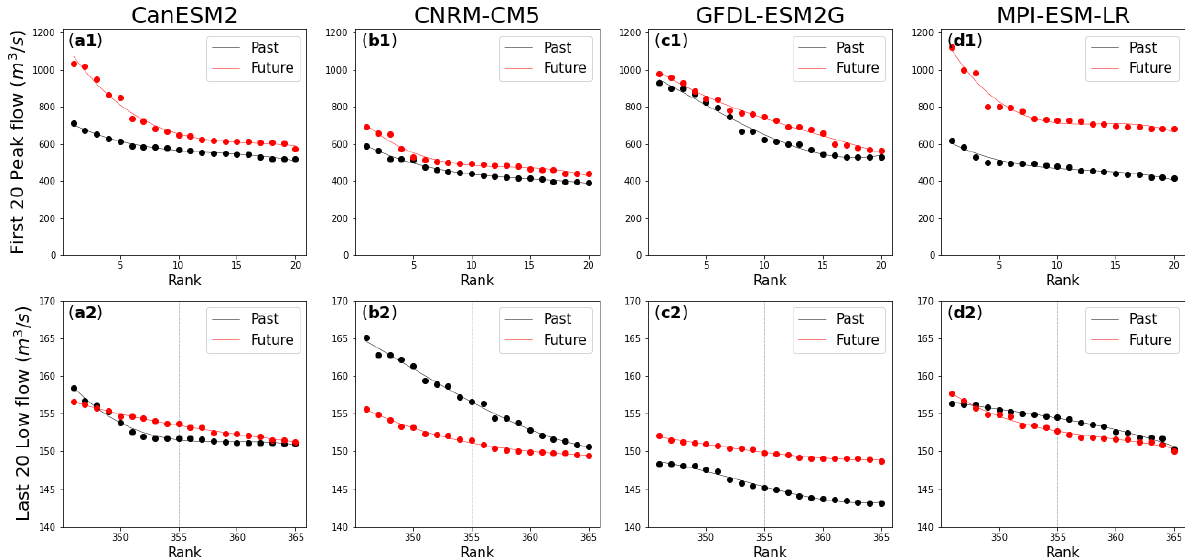
Figure 11. First 20 peak-flow events and the last 20 low-flow events of daily average discharge values of the past and future 20 years of the selected GCMs: CanESM2 ( a1 , 2 ), CNRM-CM5 ( b1 , 2 ), GFDL-ESM2G ( c1 , 2 ), MPI-ESM-LR ( d1 , 2 ).